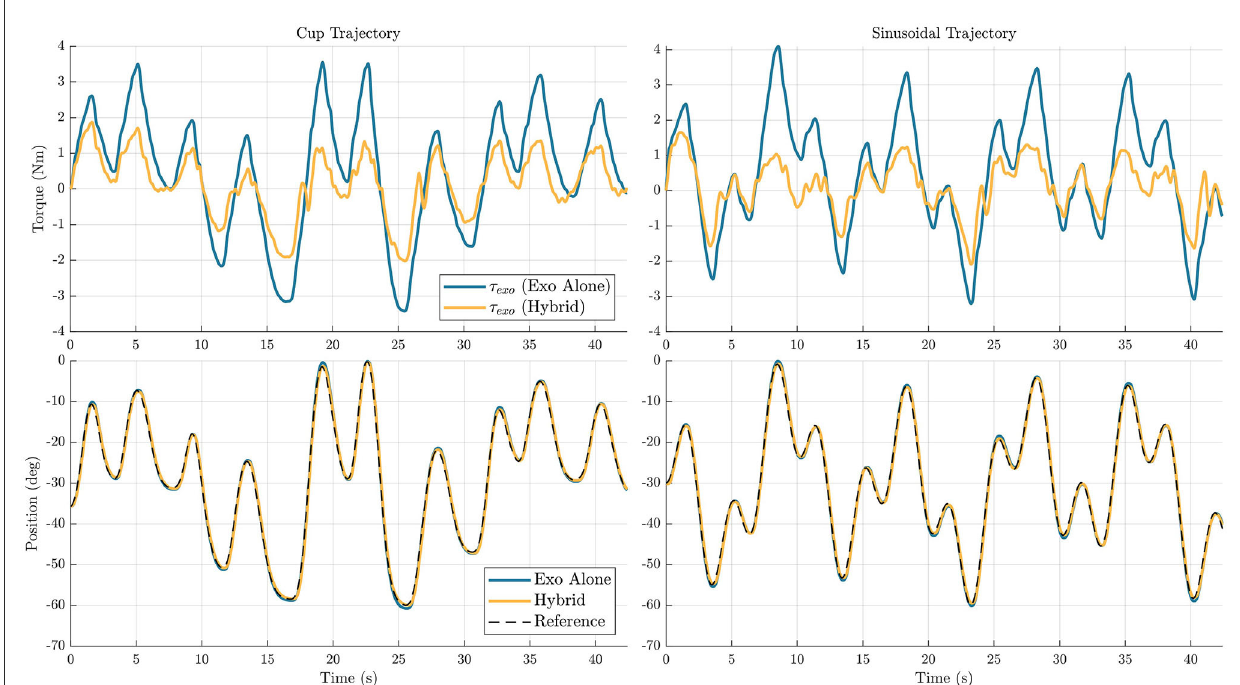
FIGURE8 Elbow flexion/extension joint exoskeleton torque profile for a single subject (top) , and movement profiles averaged across subjects (bottom) are shown for the two different trajectories, cup (left) and sinusoidal (right) . In the plots, the blue line represents data for the exoskeleton alone controller, and the yellow line represents data for the hybrid controller.